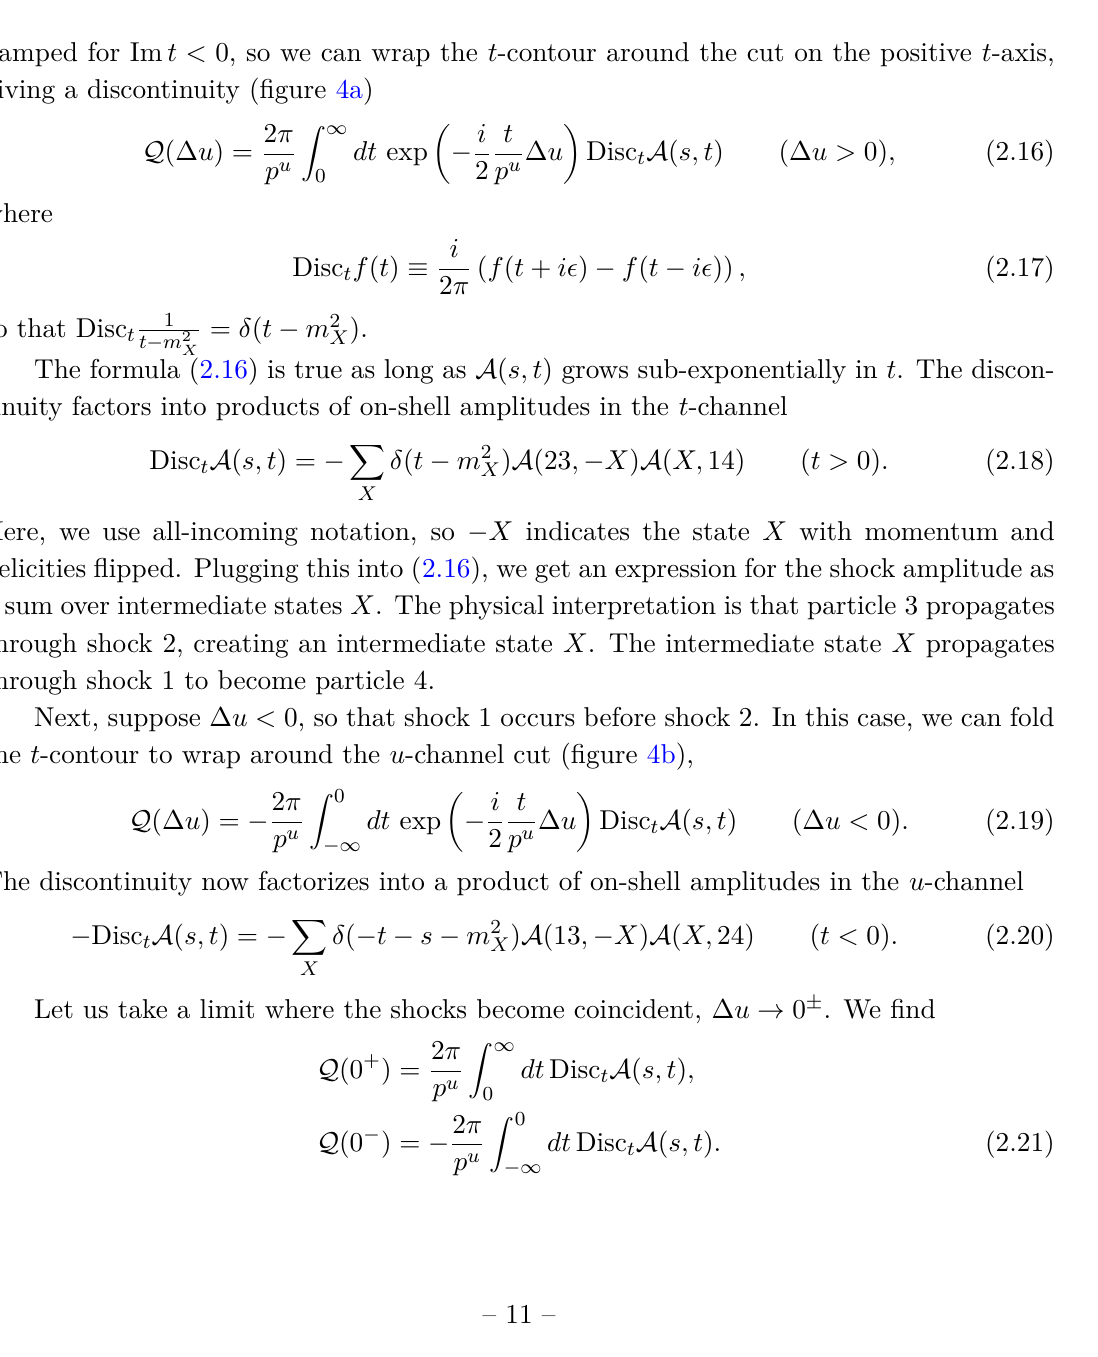
Figure 3. Integration contour for computing the shock amplitude. The integral is along the real axis, rotated by a small positive angle. The dashed lines represent t - and u -channel cuts. We assume that s < 0